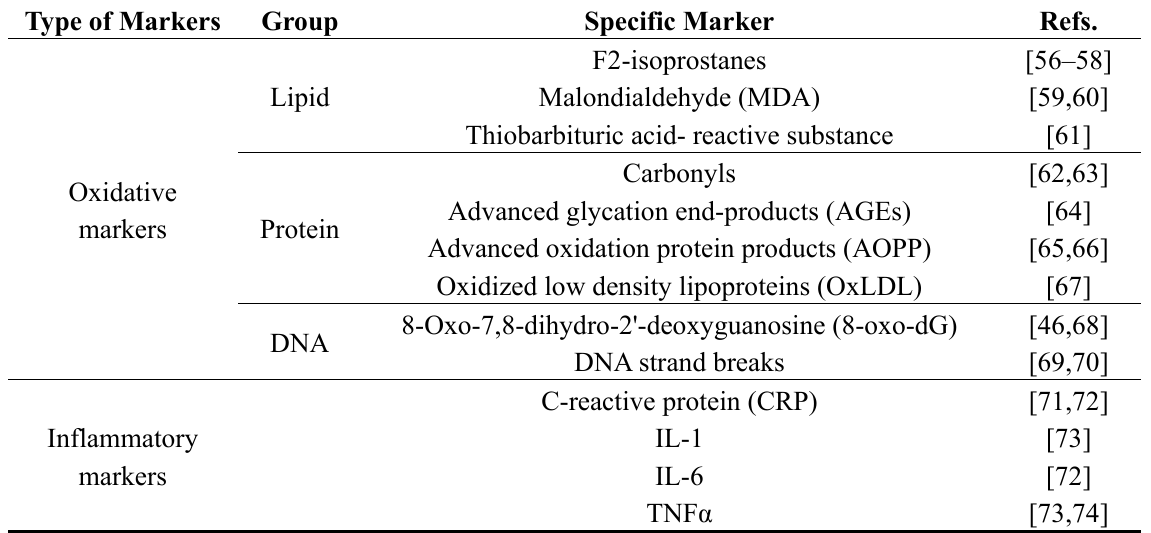
Table 1. Biological markers of oxidative stress and inflammation in CKD